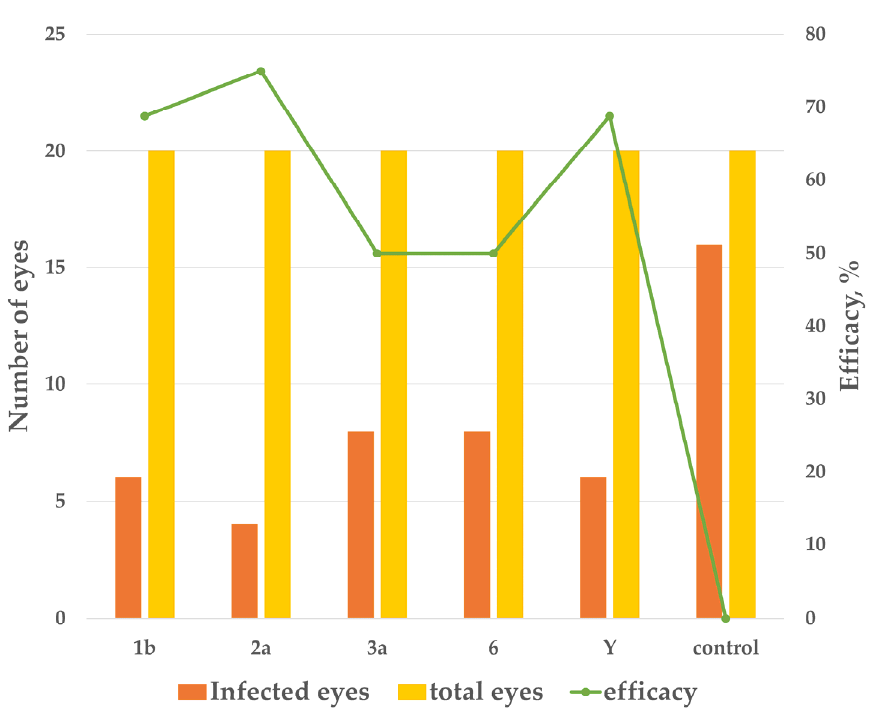
Figure 8. Protective immunity against separate infection with each of S. flexneri 1b, 2a, 3a, 6, and Y serotype was induced in guinea pigs by systemic immunization with PLVF. The control group of guinea pigs was injected with saline.